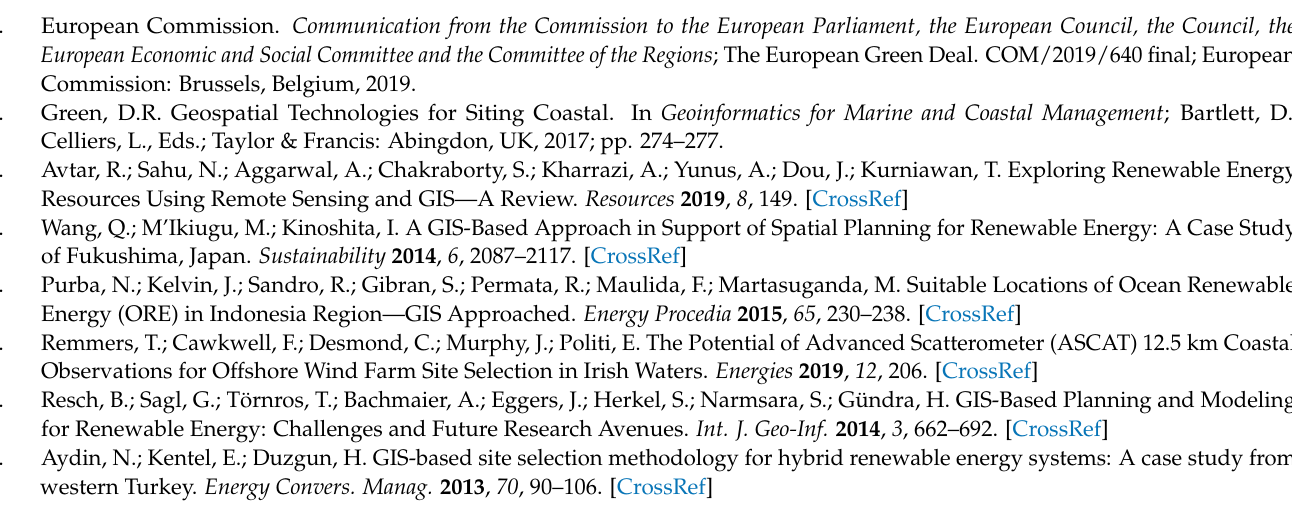
Figure A4. ( a ) the mean annual tidal energy (Wh/m 2 ), ( b ) the total annual tidal energy (MWh/m 2 ), ( c ) the mean annual neap tidal energy (Wh/m 2 ), ( d ) the total annual neap tidal energy (MWh/m 2 ), ( e ) the mean annual spring tidal energy (Wh/m 2 ) and ( f ) the total annual spring tidal energy (MWh/m 2 ).